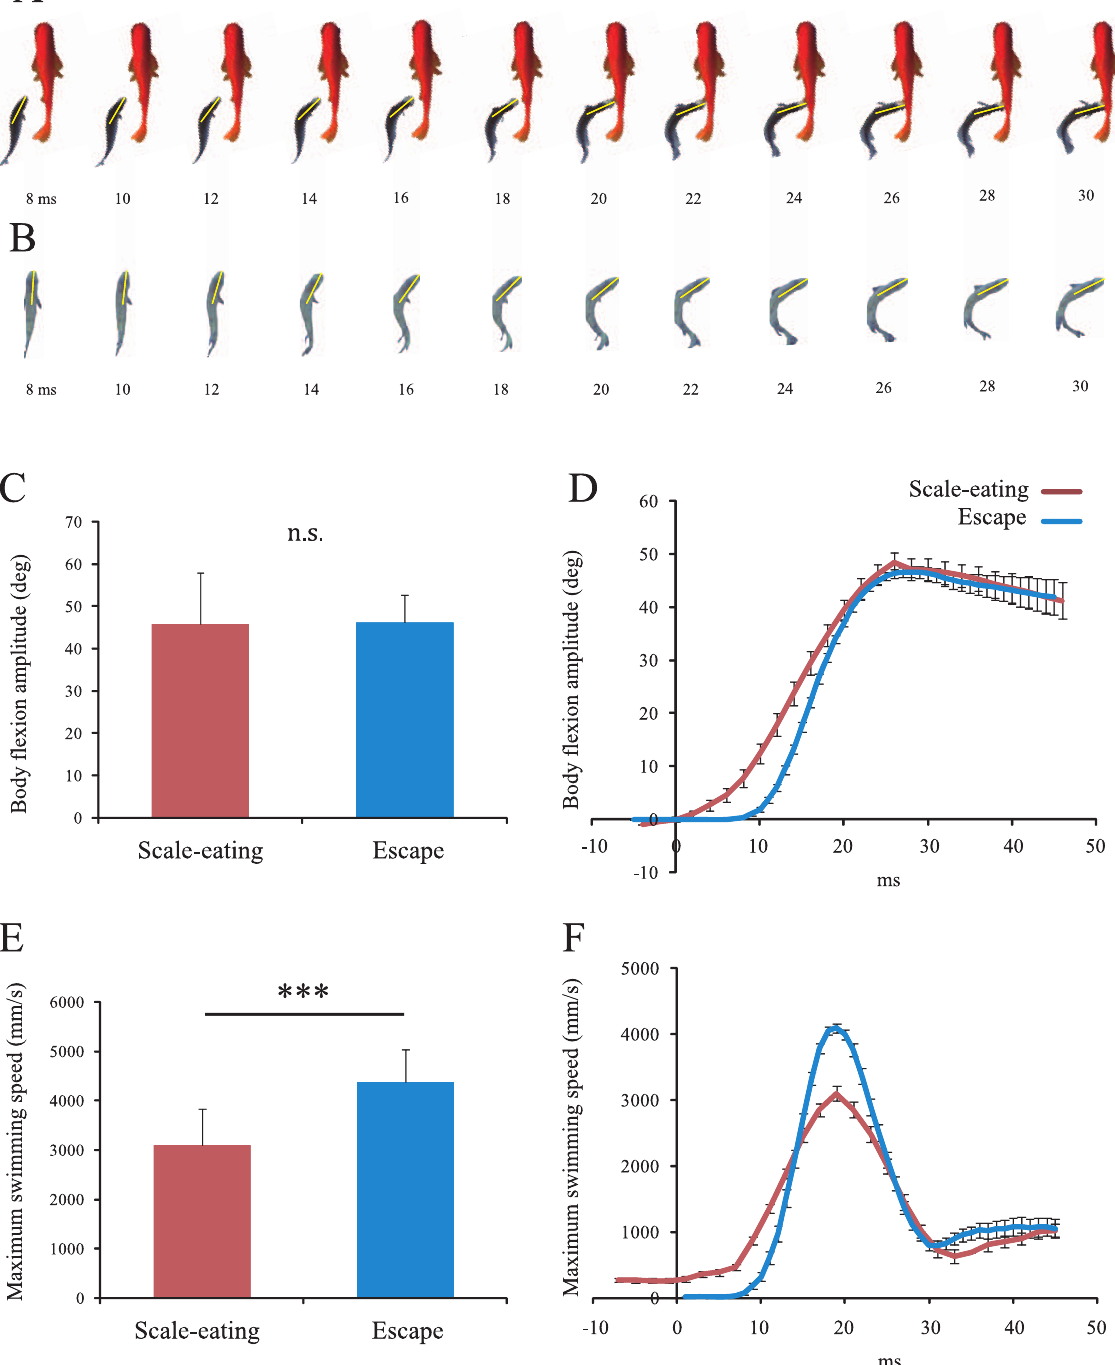
Figure 5. Comparison between scale-eating and escape behaviors. (A) Time-lapse images of P. microlepis in the bending phase of scale- eating. Yellow lines indicate the anterior midline from the snout to the center of mass. (B) An escape response elicited by acoustic stimulation consisted of a typical C-bend at the initial phase. During escape behavior, time zero was set at the time of acoustic stimulation, and maximum body flexion occurred at 26 ms. In order for the maximum body flexion angle in scale eating to occur at 26 ms after the acoustic stimulation (to match the time of occurrence of maximum body flexion in escape behavior), the time axis was adjusted. (C) The amplitude of the flexion angle (mean 6 SD) of the anterior portion of the body during scale-eating (N=39) and escape behaviors (N=63). (D) Time course of change in the flexion angle (mean 6 SE). (E) Maximum angular velocity of anterior body flexion. (F) Time course of the flexion angular velocity in scale-eating and escape behaviors. The maximum angular velocity occurred at 19 ms during escape and at 19 ms during scale eating. P-values were obtained by means of the Wilcoxon signed-rank test. **p , 0.001, n.s., not significant.